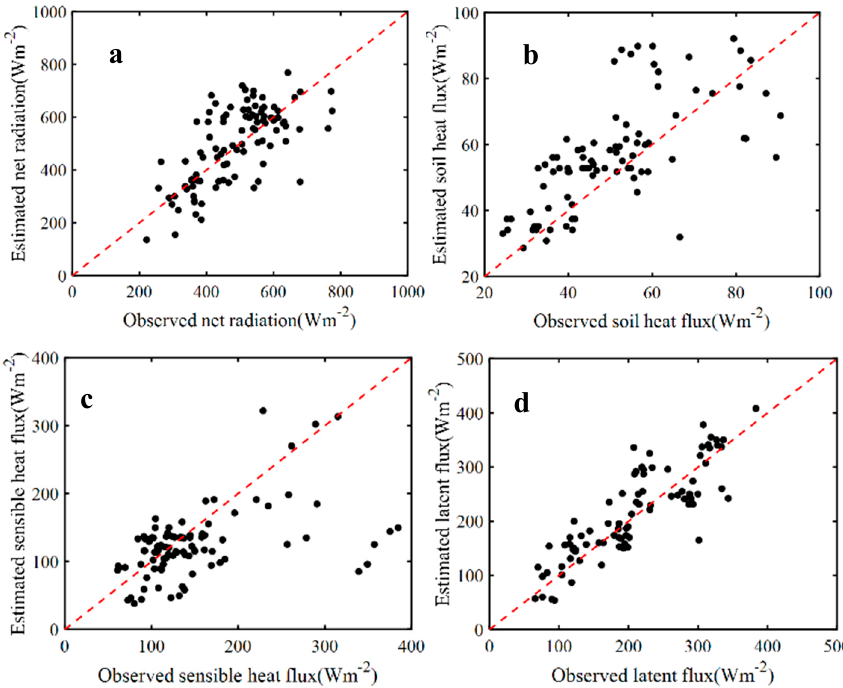
Figure 5. Comparisons between hourly surface energy flux measurements and the estimated: ( a ) net radiation, ( b ) soil heat flux, ( c ) sensible heat flux, ( d ) latent heat flux.